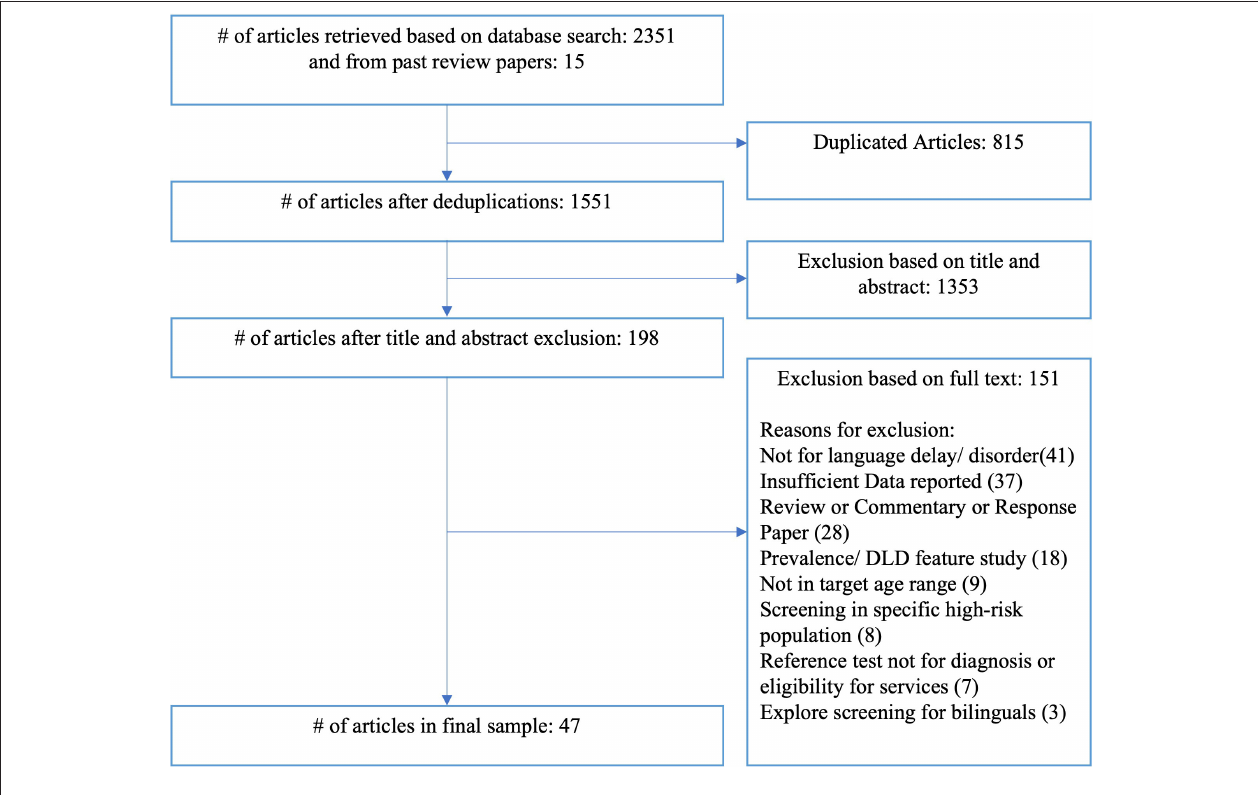
FIGURE 1 | Flow-chart for the inclusion and exclusion of articles in literature search.